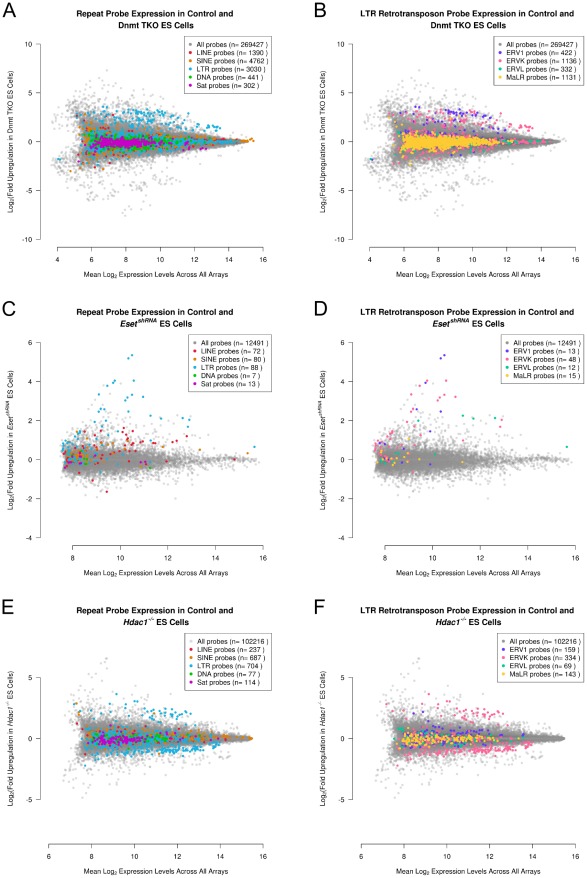
Different transcriptional silencing mechanisms have distinct effects on genome-wide repression of repetitive elements.(A, B) MA-plots for Dnmt1−/− Dnmt3A−/− Dnmt3B−/− triple knockout (Dnmt TKO) ES cell Affymetrix Gene Expression data. The mean expression level for each expressed probe is plotted against the fold upregulation of that probe in Dnmt TKO ES cells. Probes for repeat families (A), and classes of LTR retrotransposons (B) are colour-coded in each plot according to the legend. A group of ERV1 and ERVK LTR retrotransposons can be seen to be upregulated relative to the total probe population in the Dnmt TKO ES cells. (C, D) MA-plots for EsetshRNA ES cell Illumina Beadchip data with probes for repeat families (C), and classes of LTR retrotransposons (D) colour-coded according to the legend. Probes for different ERV1, ERVK and ERVL LTR retrotransposon families are strongly upregulated, and multiple LINE-1 probes are modestly upregulated, in EsetshRNA ES cells. (E, F) MA-plots for Hdac1−/− ES cell Affymetrix Gene Expression data with probes for repeat families (E), and classes of LTR retrotransposons (F) colour-coded according to the legend. One group of ERVK LTR retrotransposon probes is upregulated in Hdac1−/− ES cells, another group is downregulated.